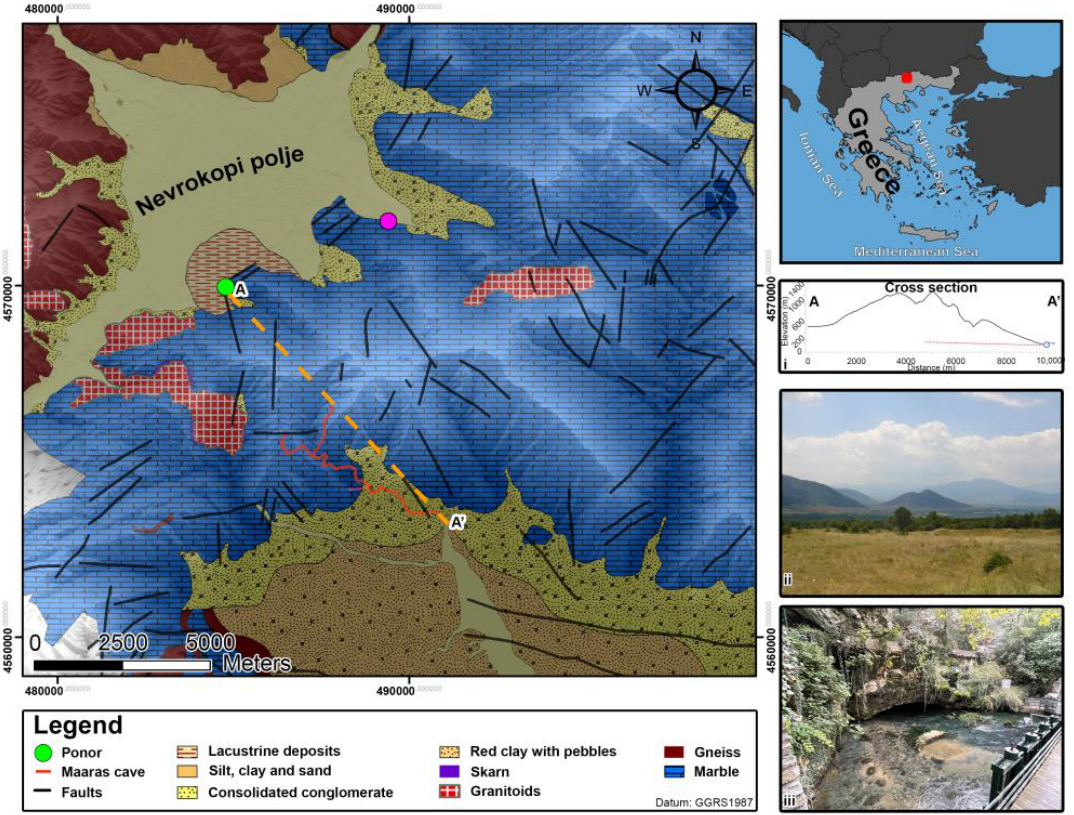
Figure 1. Geological map of the broader area of the Nevrokopi—Maaras karstic system (based on Pennos et al. [33] and references within). The magenta circle shows the position of the NOA station [35]. ( i ) Shows a topographic cross section from the ponor (A) to the spring (A’) and the red dashed line corresponds to the longitudinal projection of Maaras cave. ( ii ) View of the Nevrokopi Polje from the area of the meteorological station. ( iii ) View of the Aggitis spring (i.e., entrance of Maaras cave).